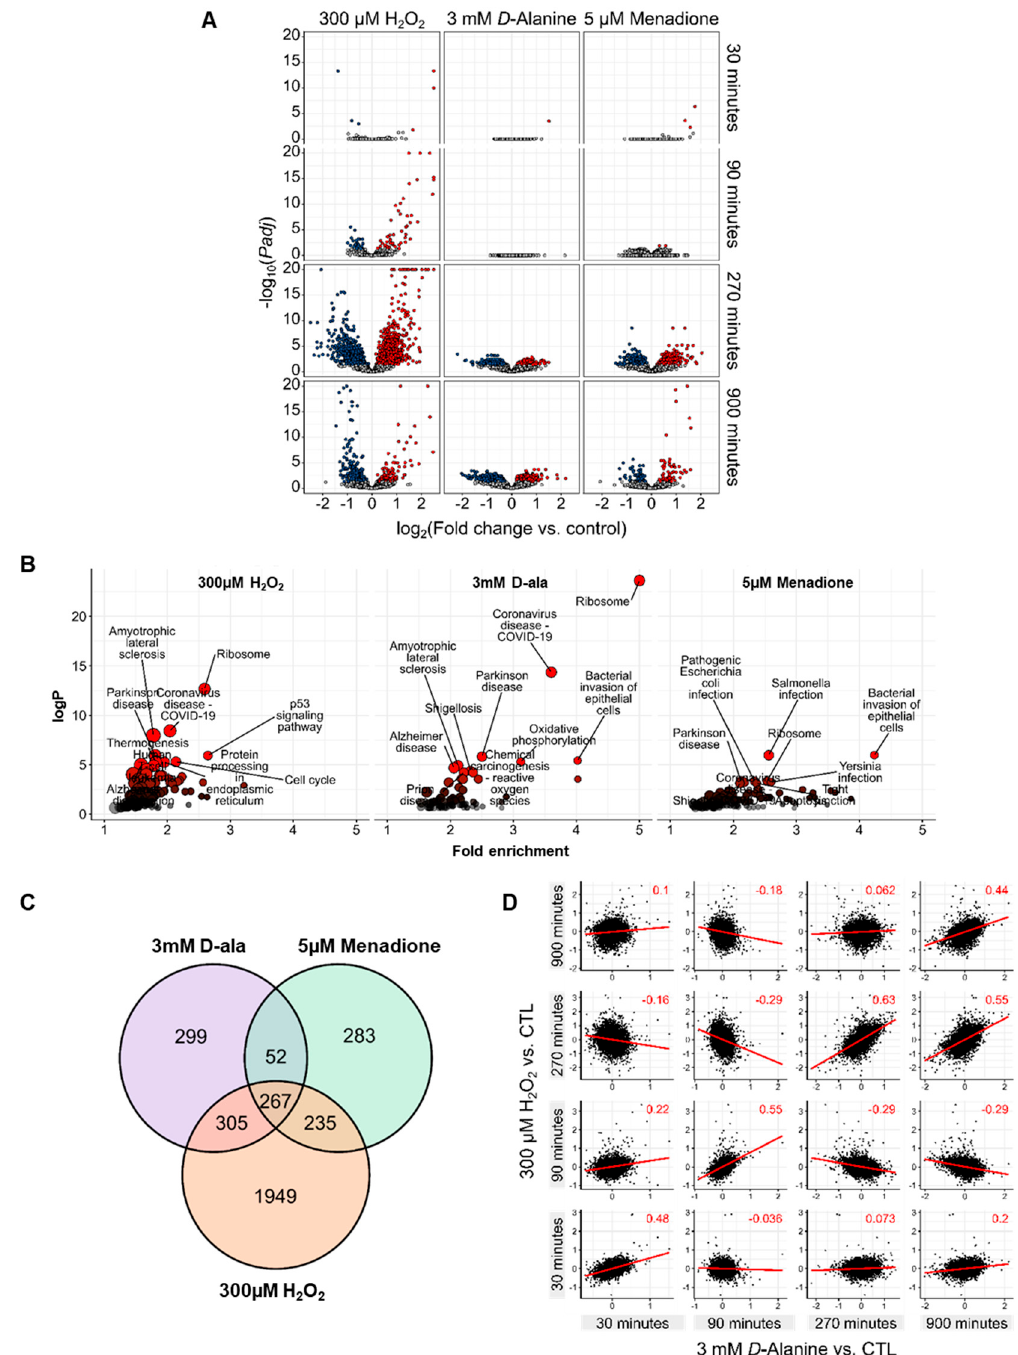
Figure 4. Different ROS lead to a different time-dependent transcriptomic response of HUVEC. ( A ): Differentially expressed genes after stimulation with 300 µ M H 2 O 2 , 3 mM D-alanine or 5 µ M menadione over the course of 30, 90, 270 and 900 min (significantly changed genes (p adj < 0.05) are highlighted in blue and red). ( B ): Pathway annotation of significantly altered genes in A. ( C ): Venn diagram of significantly regulated genes in the treatments as indicated. ( D ): Correlation analysis for significantly DEGs comparing exogenous versus DAO-derived H 2 O 2